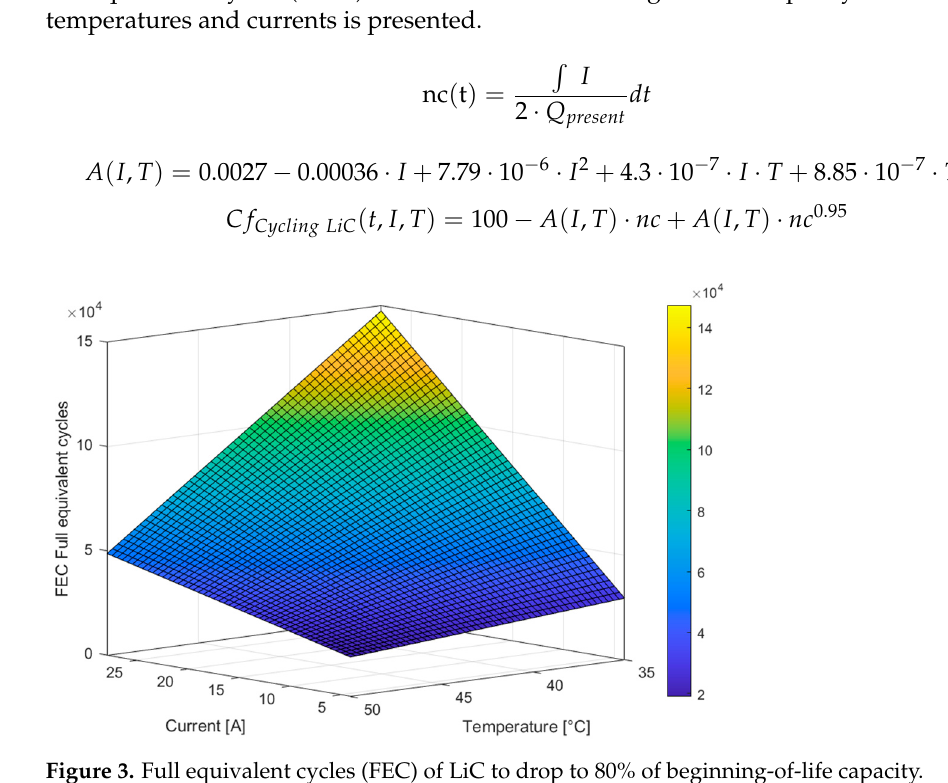
Figure 3. Full equivalent cycles (FEC) of LiC to drop to 80% of beginning-of-life capacity.